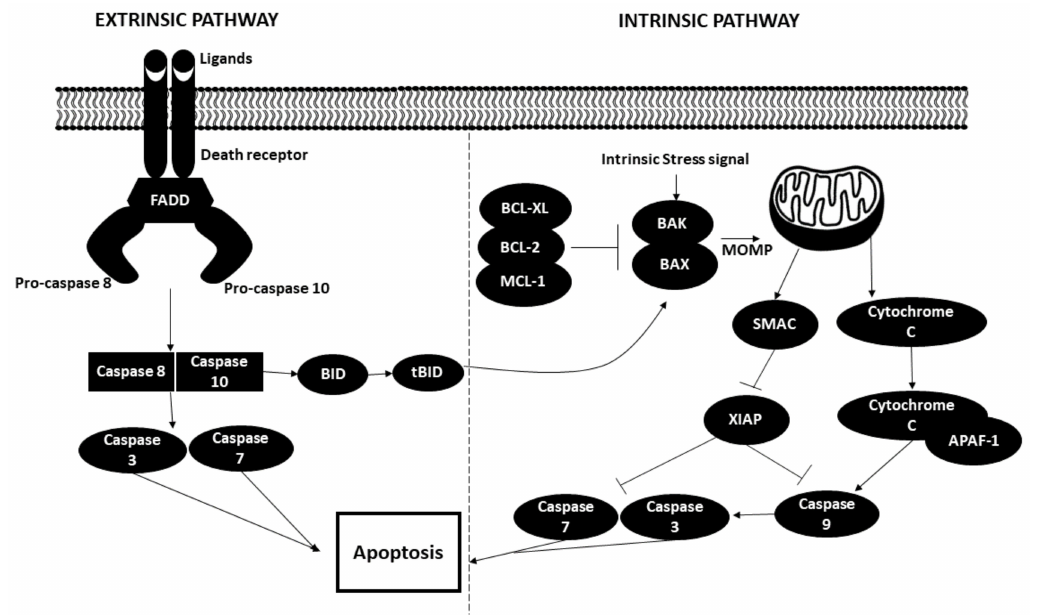
Figure 5. Extrinsic and intrinsic pathways in apoptosis. BID: BH3-interacting domain death agonist; BCL-xL: B cell lymphoma extra-large; BCL-2: B cell lymphoma 2; MCL-1: myeloid cell leukemia sequence 1; BAK: Bcl-2 homologous antagonist killer; BAX: Bcl-2-associated X protein; MOMP: mitochondrial outer membrane permeabilization; SMAC: Second mitochondrial derived activator of caspases; XIAP: X-linked inhibitor of apoptosis protein; APAF-1: Apoptotic protease activating factor 1.